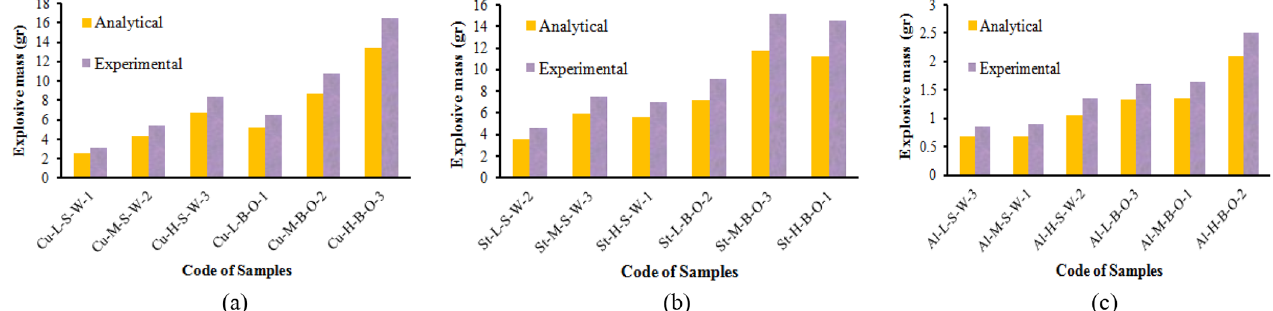
Fig. 8. Analytical and experimental explosive mass for (a) copper, (b) steel, (c) aluminum